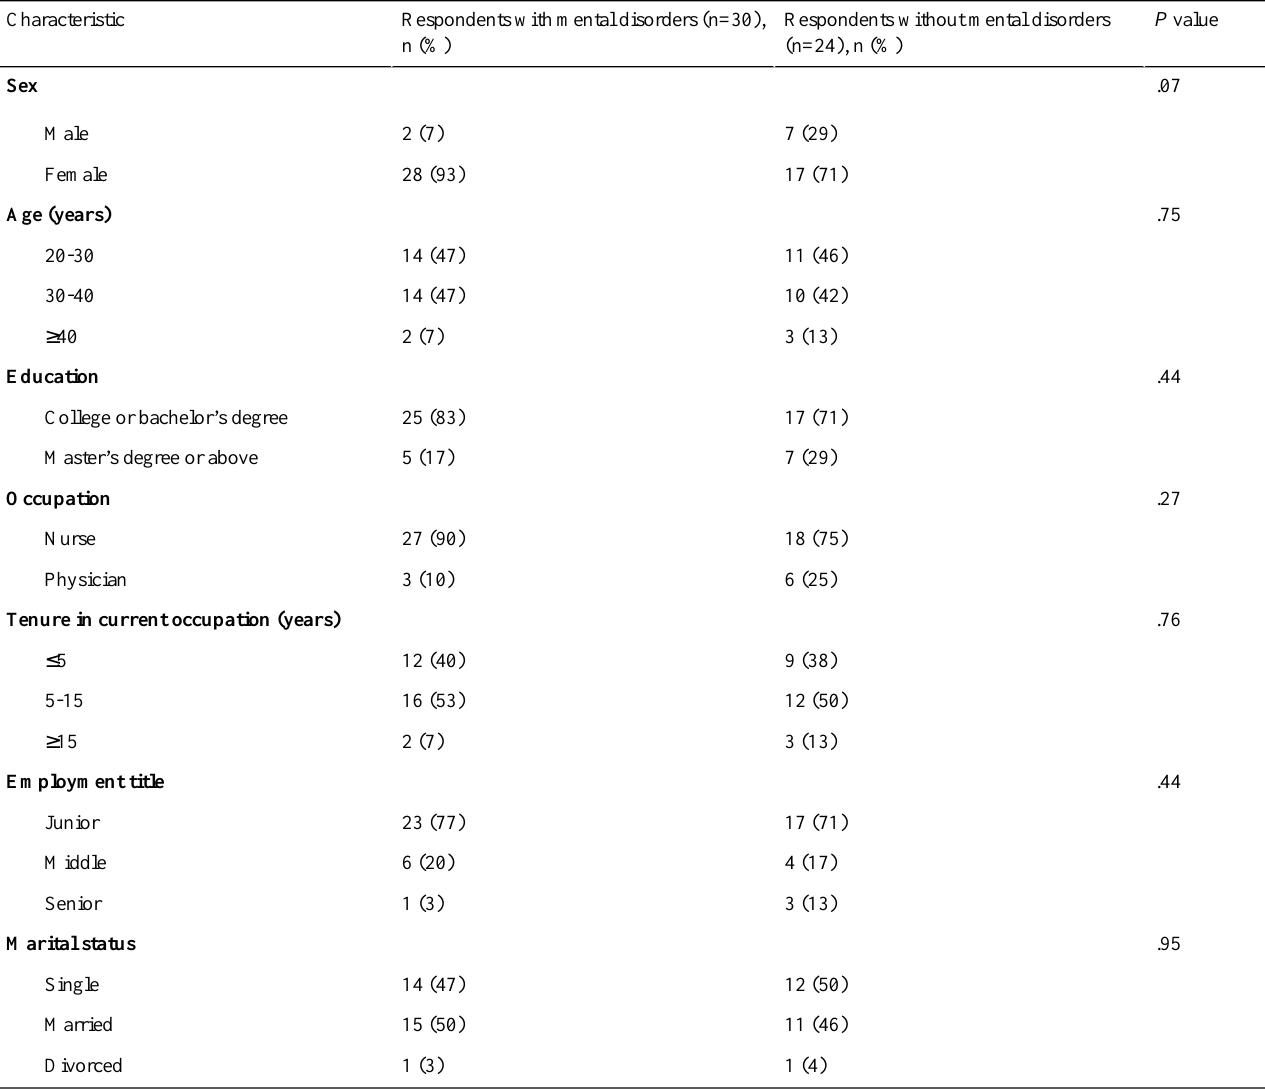
Table 1. Demographic characteristics of the frontline clinicians at Wuhan First Hospital (N=54).